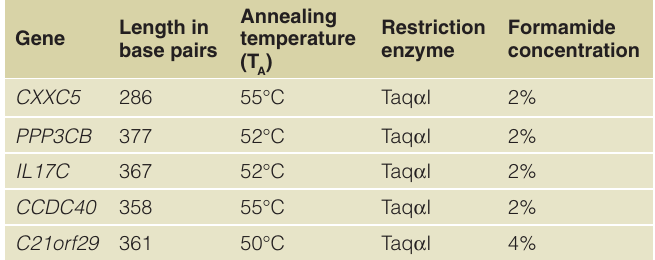
Supplementary Table 2. PCR parameters.